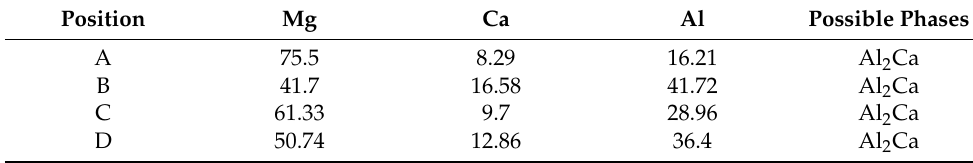
Figure 5. SEM micrographs of the extruded sheets: ( a ) alloy 1, ( b ) alloy 2, ( c ) alloy 3, and ( d ) alloy 4. A–D are point EDS of the second phases. Table 3. EDS analysis of the second phases on the extruded sheets marked in Figure 4.